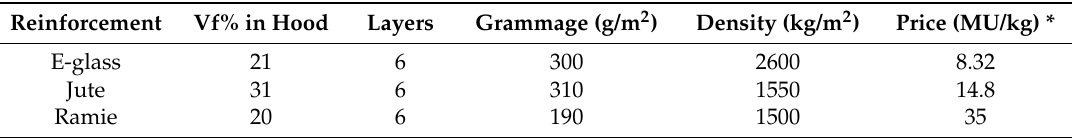
Table 5. Reinforcement related characteristics.